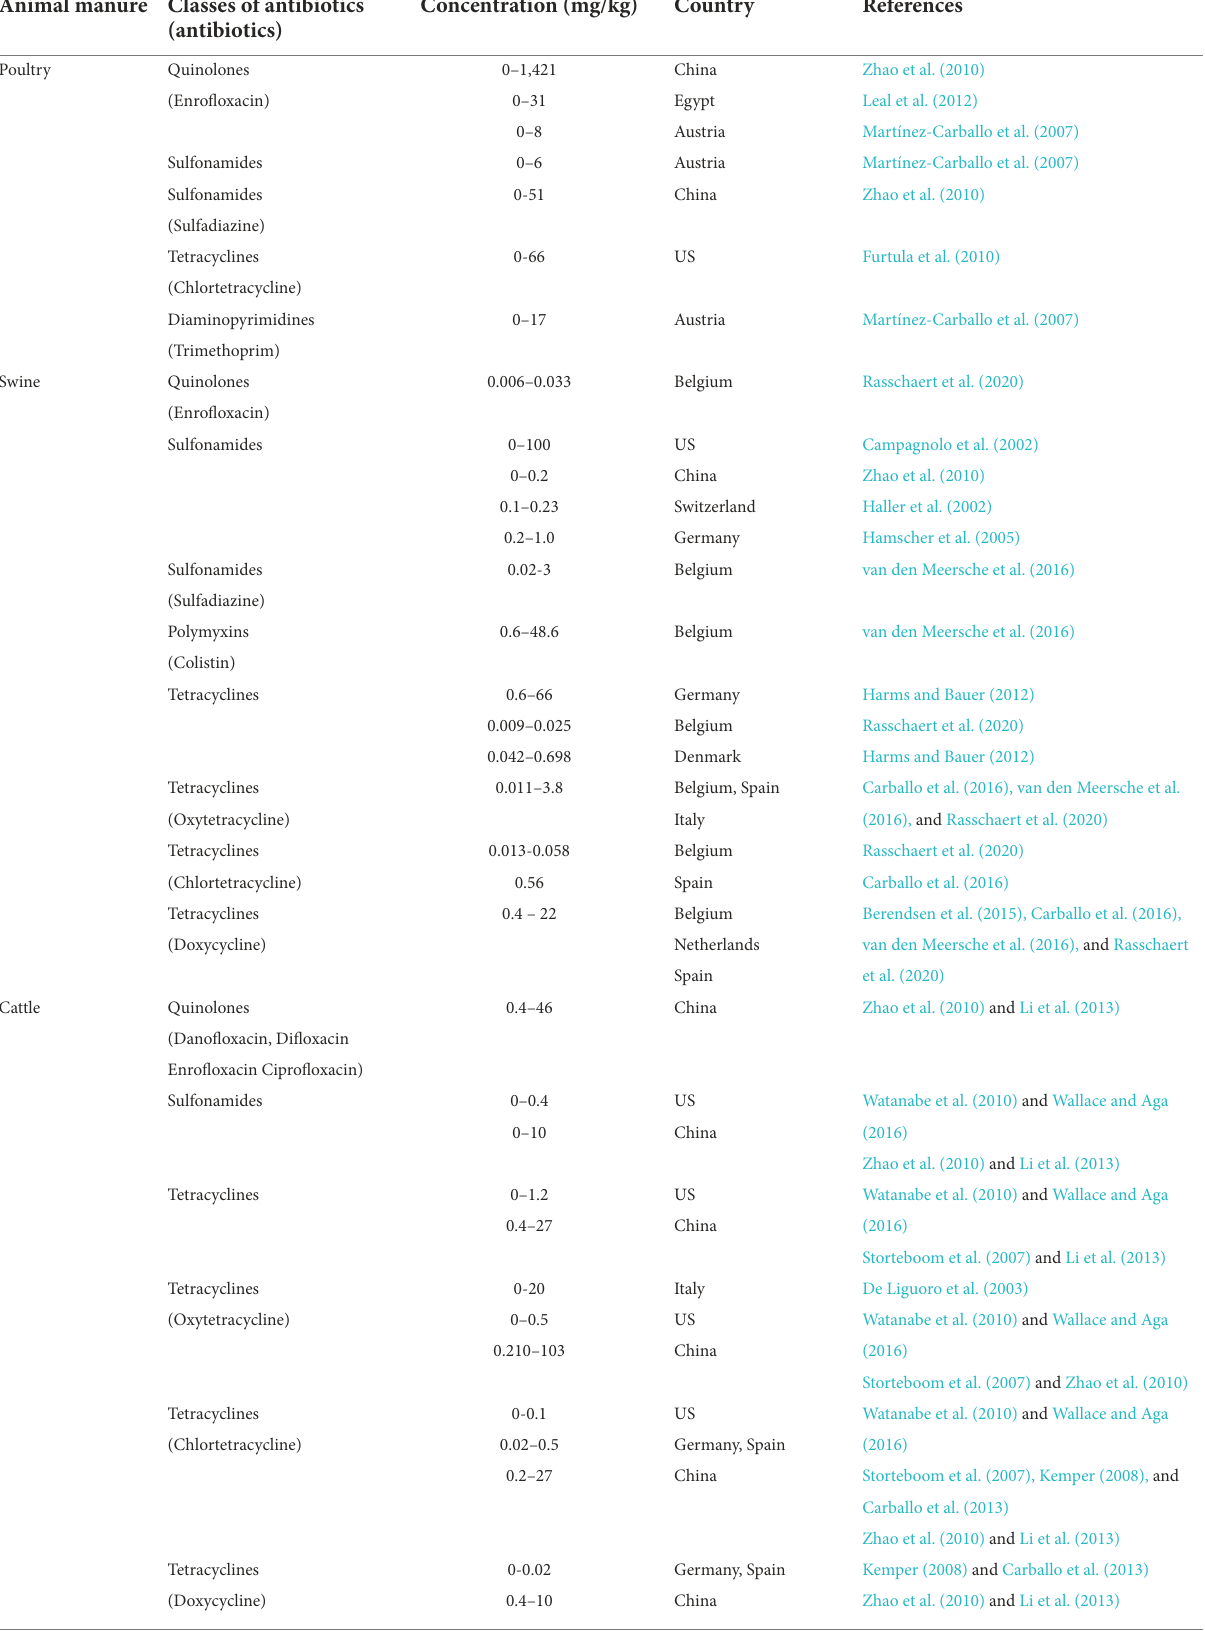
TABLE 1 The amount of antibiotics detected in poultry, swine and cattle manure in different countries. Animal manure Classes of antibiotics